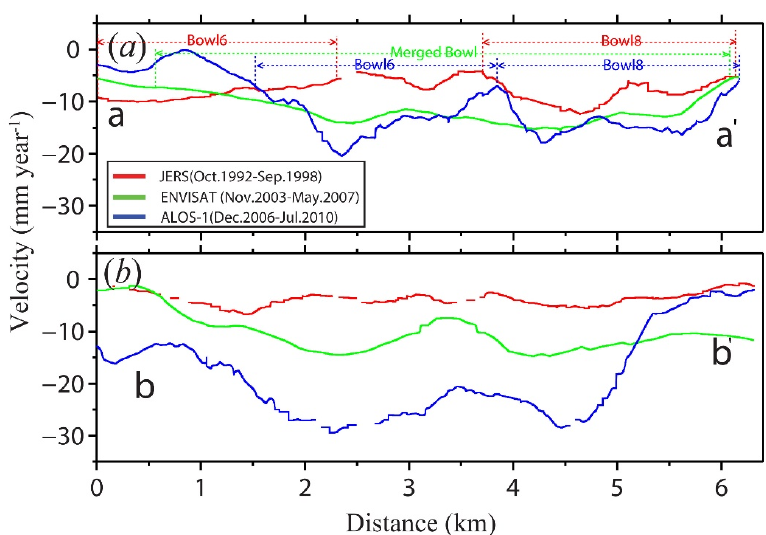
Figure 9. Two bowl subsidence profiles (aa’ and bb’) in Figure 7. ( a ) aa’ profile going through subsidence bowl 6 and bowl 8 in the urban area. Two separated bowls, i.e., Bowl 6 and Bowl 8, represented by red merged into one bowl represented by green, and then became two connected bowls represented by blue; ( b ) bb’ profile going through subsidence bowl 9 in the suburban area, the mean velocity grows with increase of time. The red, green and blue solid lines represent the mean velocity of JERS, ENVISAT and ALOS1 datasets.